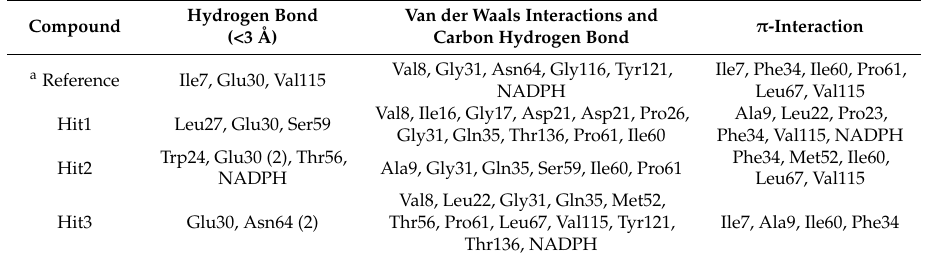
Figure 9. Molecular interactions analyses. The reference compound and the three hit compounds interacted essential residues in the active site of hDHFR. The reference compound ( A ), Hit1 ( B ), Hit2 ( C ), and Hit3 ( D ) are depicted as a red, magenta, green, and orange colored stick representation. The H-bond forming residues of hDHFR are displayed as cyan stick model. H-bonding and bond distance are represented as green dashed lines and measured in angstrom (Å), respectively. Table 6. Molecular interactions between the ligands (the reference and hit compounds) and the active site residues of hDHFR.